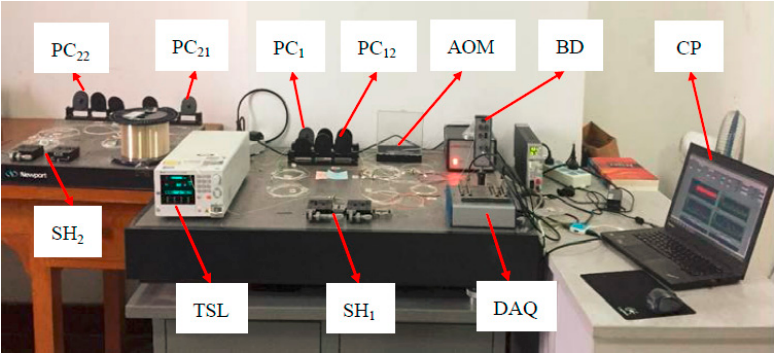
Figure 2. The experimental setup of the dual-point strain FSI-FLRD detection system. TSL: tunable semiconductor laser; PC i1 , PC i2 : polarization controller; SH i : sensor head; AOM: acousto-optic modulator; BD: balanced detector; DAQ: data acquisition card; CP: Computer.